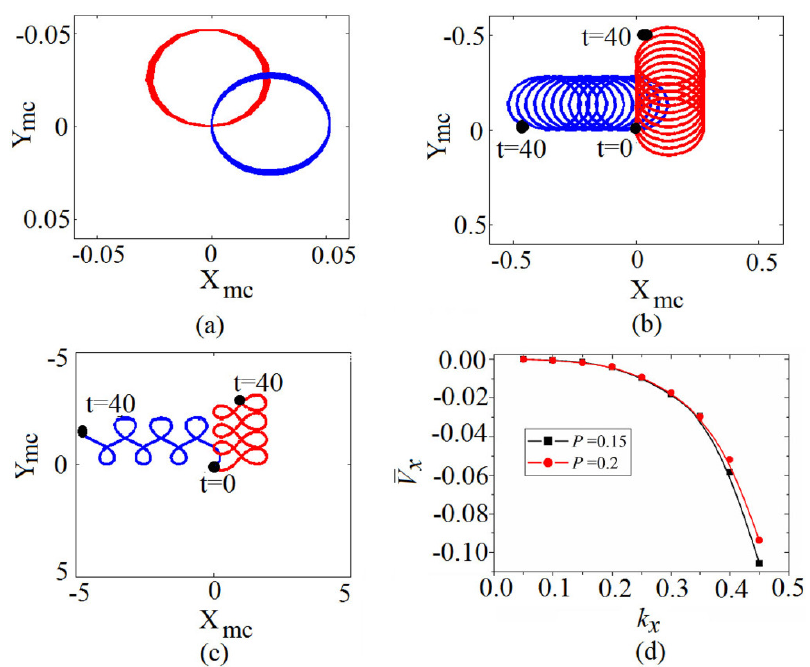
Figure 3. Motion of the c.m. of kicked symmetric vortex solitons (SVS) with N = 0.15. ( a ) The kick k = ( k x , k y ) = ( 0.05,0 ) (blue) and ( 0,0.05 ) (red), pinning in a circle. ( b ) k = ( 0.25,0 ) (blue) and ( 0,0.25 ) (red), spiral motion. ( c ) k = ( 0.5,0 ) (blue) and ( 0,0.5 ) (red), “lacy” motion. ( d ) Mean velocity of the spiral motion for N = 0.15 and 0.2